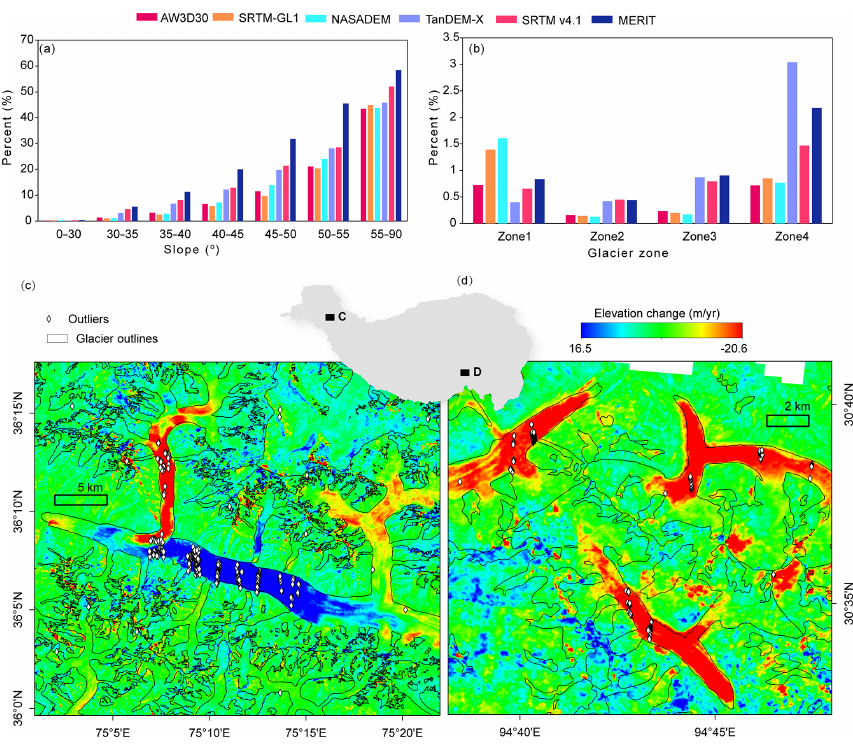
Figure 10. Distribution of excluded extreme outliers. The proportion of outliers accounting for the total number in slope bins (a) and each glacier zone (b) . Examples of locations of excluded points overlaid with glacier surface elevation change in the Karakoram (c) and southern TP (d) . Locations of these two examples in (c) and (d) are labeled C and D in the central insert, respectively. Glacier elevation change data covering 2000–2019 are from Shean et al.